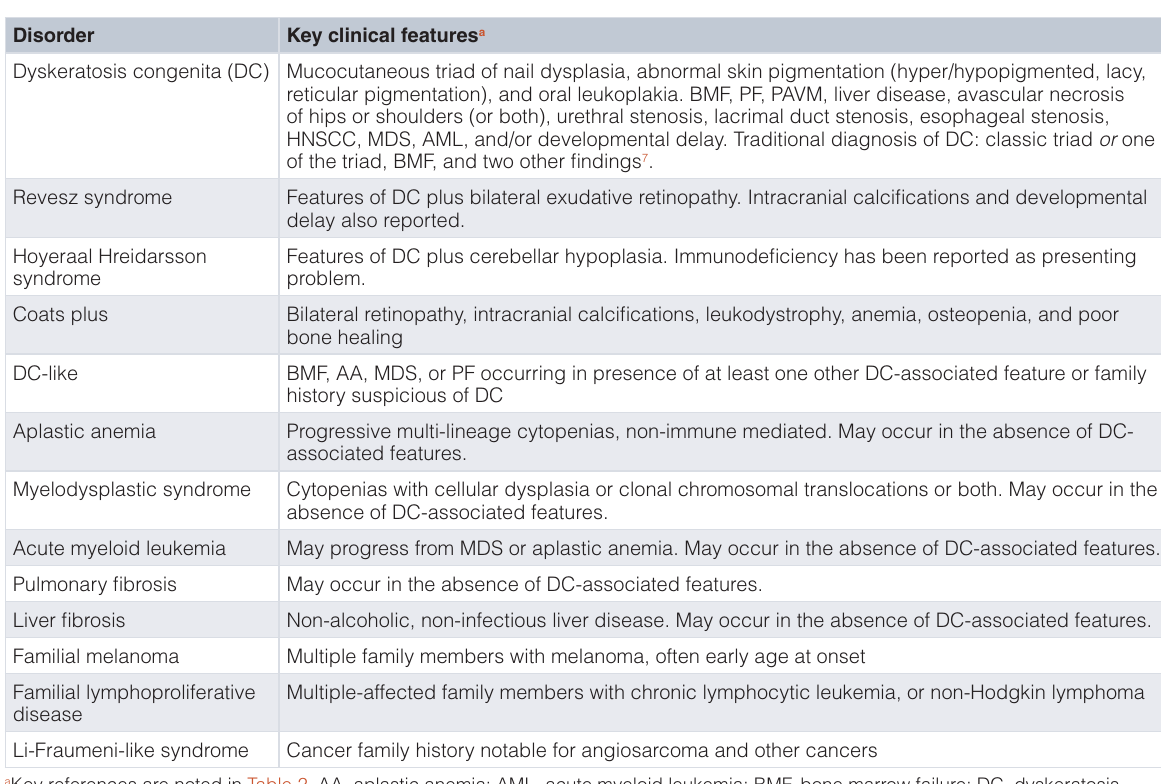
Table 1. Clinical features of telomere biology disorders. Disorder Key clinical features